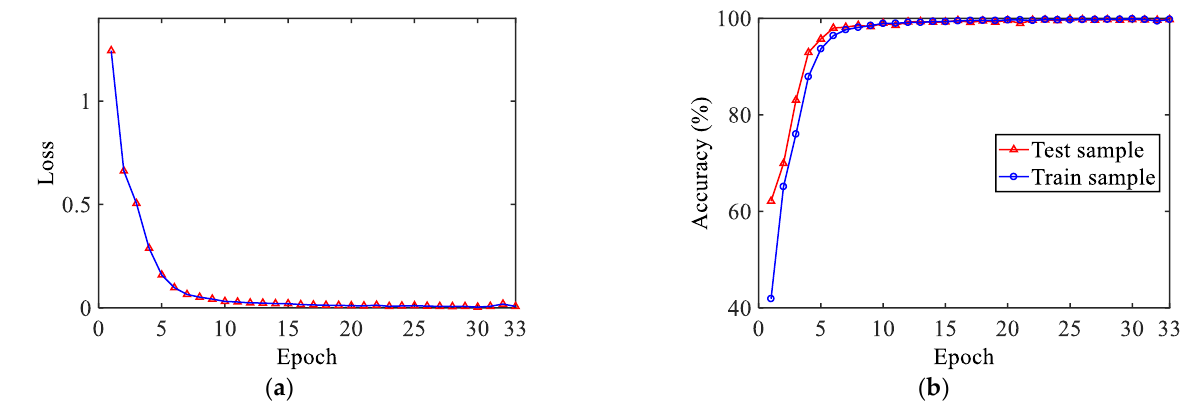
Figure 26. Trend of loss and identification accuracy. ( a ) Loss , ( b ) accuracy .